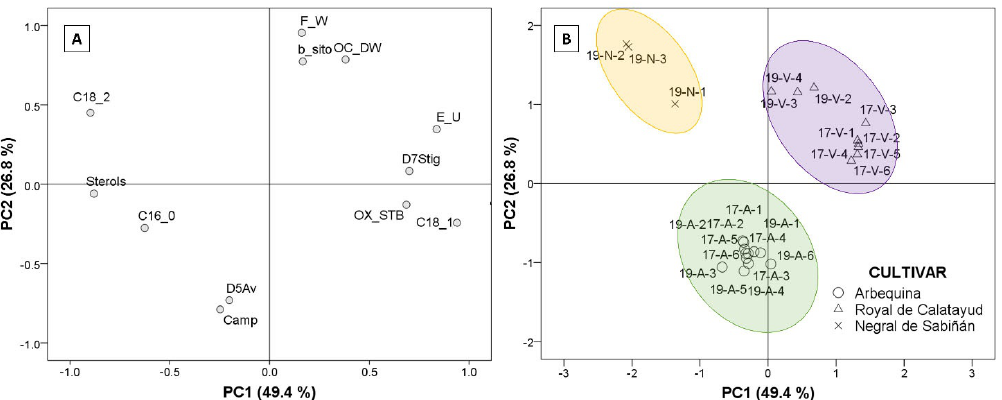
Figure 6. Plots of factor analysis loadings ( A ) and scores ( B ) of Principal Component Analysis (PCA) for the dataset. Cultivar: “Negral de Sabiñán” (N), “Royal de Calatayud” (V), and “Arbequina” ( A ).